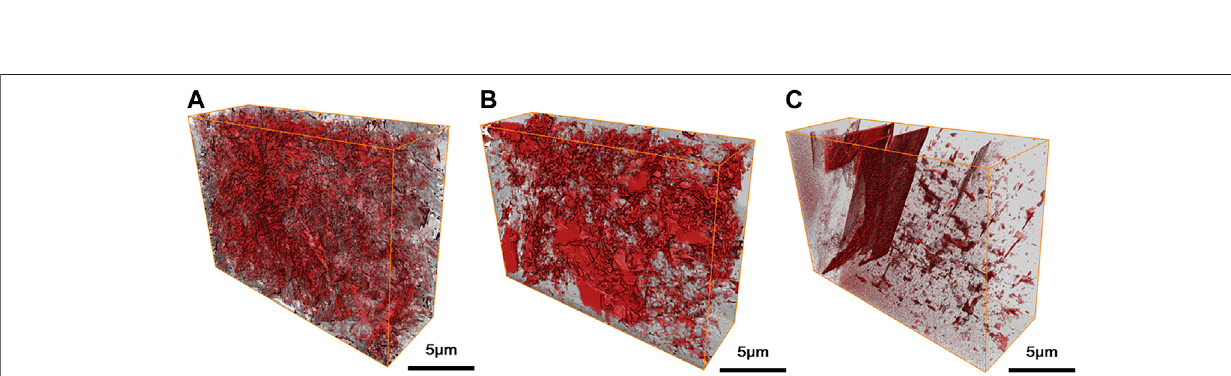
Frontiers in Earth Science |